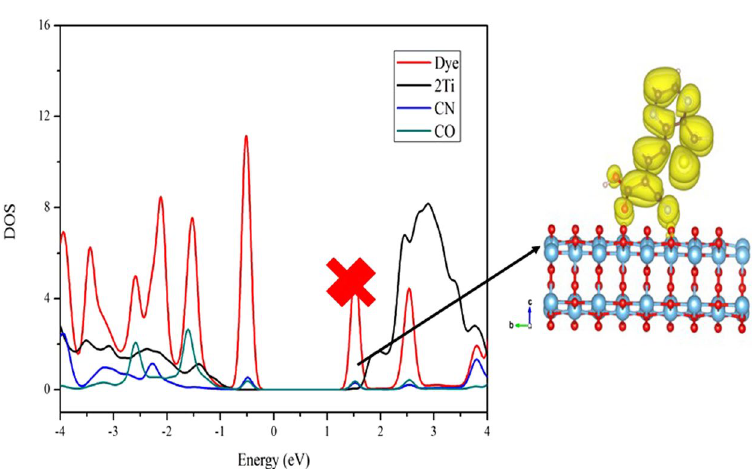
Figure 7. The DOS plot for the model dye adsorption configuration B4 along with its partial charge density for the band corresponds to long wavelength absorption band; isovalue 0.0004